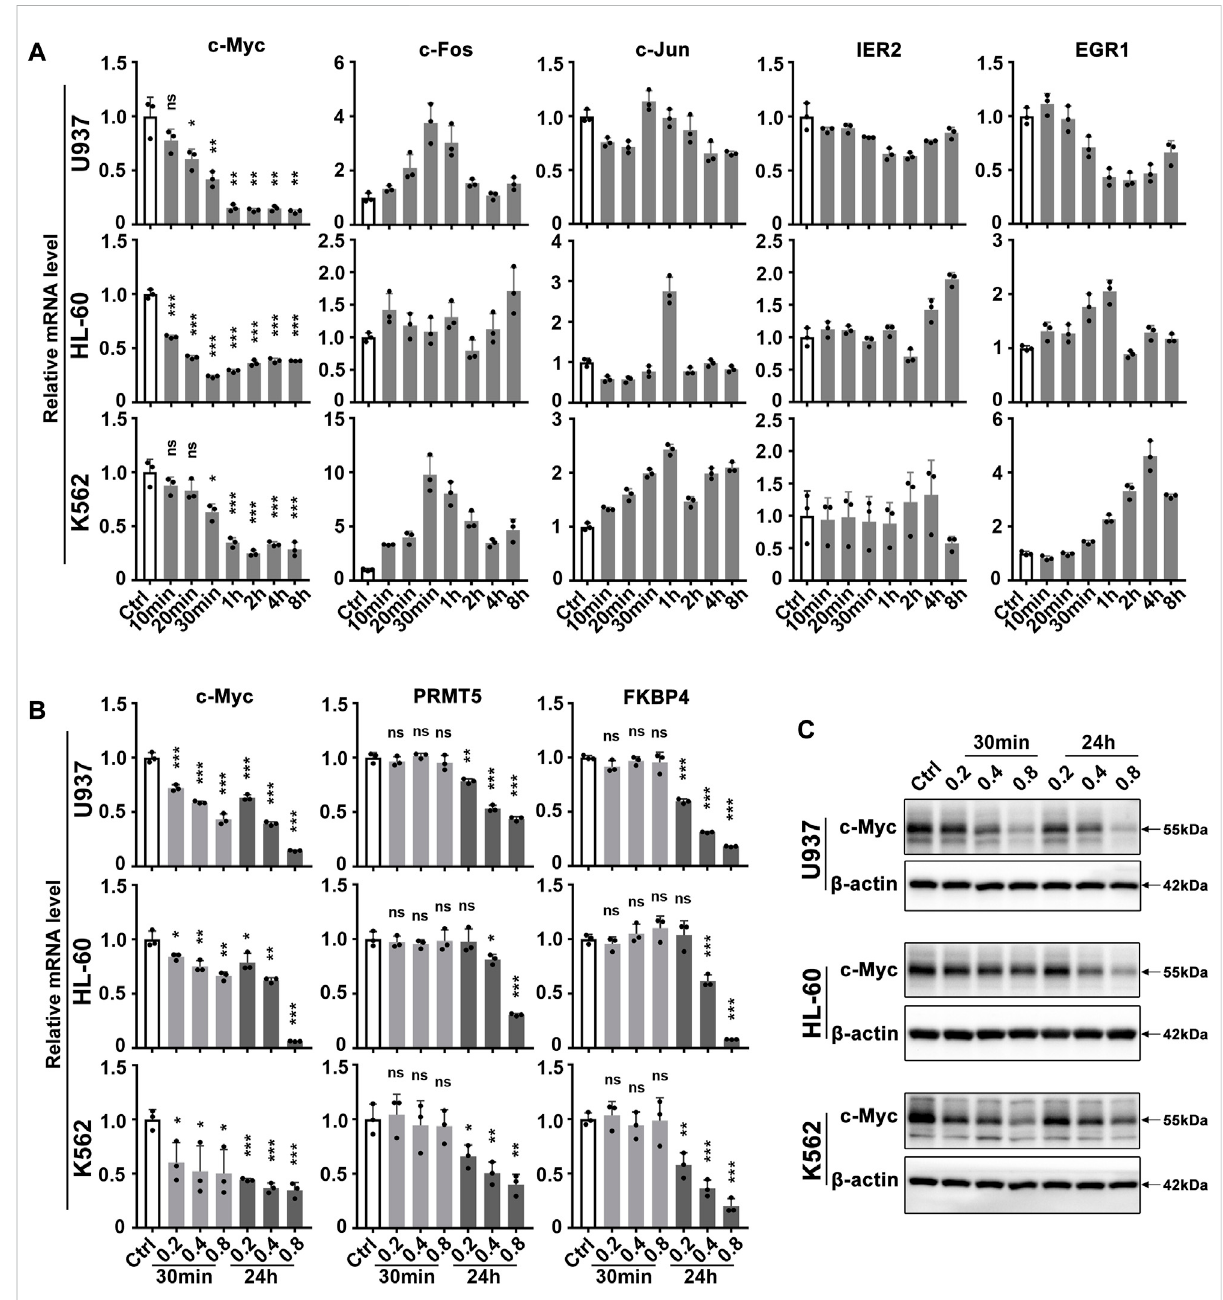
FIGURE 1 c-Myc responds rapidly to matrine treatment. (A) Effects of matrine on mRNA levels of immediate early genes in myeloid leukemia cell lines. U937, HL-60 and K562 cell lines were treated with 0.8 mg/ml matrine for different time and then subjected to qPCR. (B,C) Effects of matrine on expression of c-Myc and its targets. U937, HL-60 and K562 cell lines were treated with 0.2, 0.4 and 0.8 mg/ml matrine for 30 min and 24h, respectively, and then subjected to qPCR (B) or western blotting (C) . β -actin was used as an internal control. Data are shown as mean ± SEM of three independent replicates and unpaired t-test was carried out to detect signi fi cance (A,B) . ns, * p < 0.05, ** p < 0.01, *** p < 0.001 vs. Ctrl. Abbreviations: Ctrl, control; ns, no signi fi